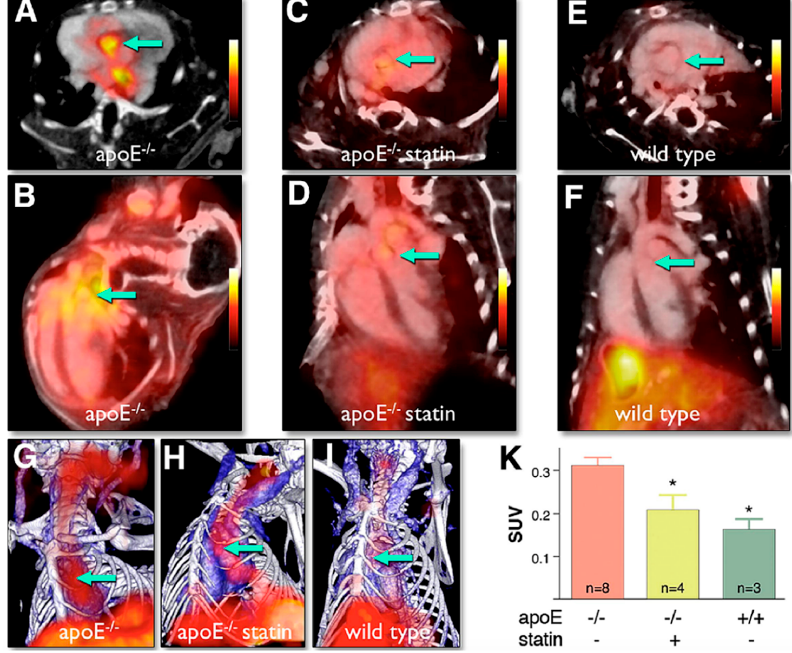
Figure 7. PET-CT in ApoE − / − and statin-treated mice. PET-CT imaging shows uptake of 18 F-4V in the aortic root (arrows) and arch of atherosclerotic mice. Uptake is lower in statin-treated and in wild-type mice. ( A , C , E ) Short-axis views; ( B , D , F ) Long-axis views; ( G , H , I ) Three-dimensional maximum intensity projection. Bone is shown in white, vasculature in blue, and 18 F-4V PET signal to the strong uptake of 18 F-4V PET observed in the root and arch (arrow). K = quantification of